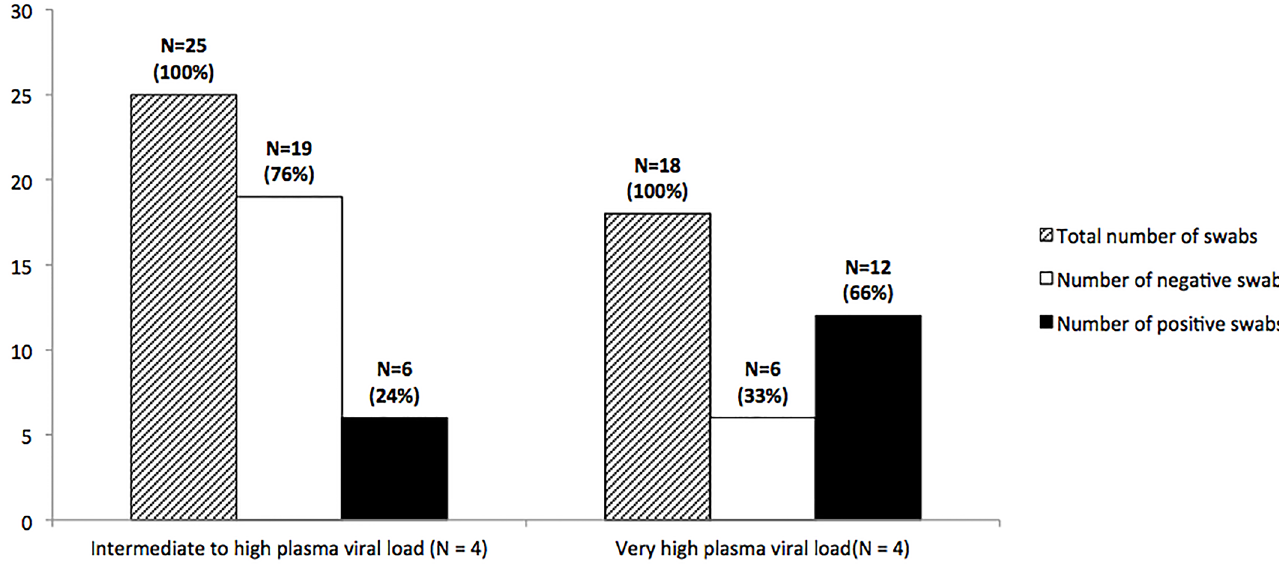
Fig 2. Number of positive (EBOV RNA+) and negative (EBOV RNA-) swabs from close proximity of patients with intermediate to high or very high EBOV plasma viral